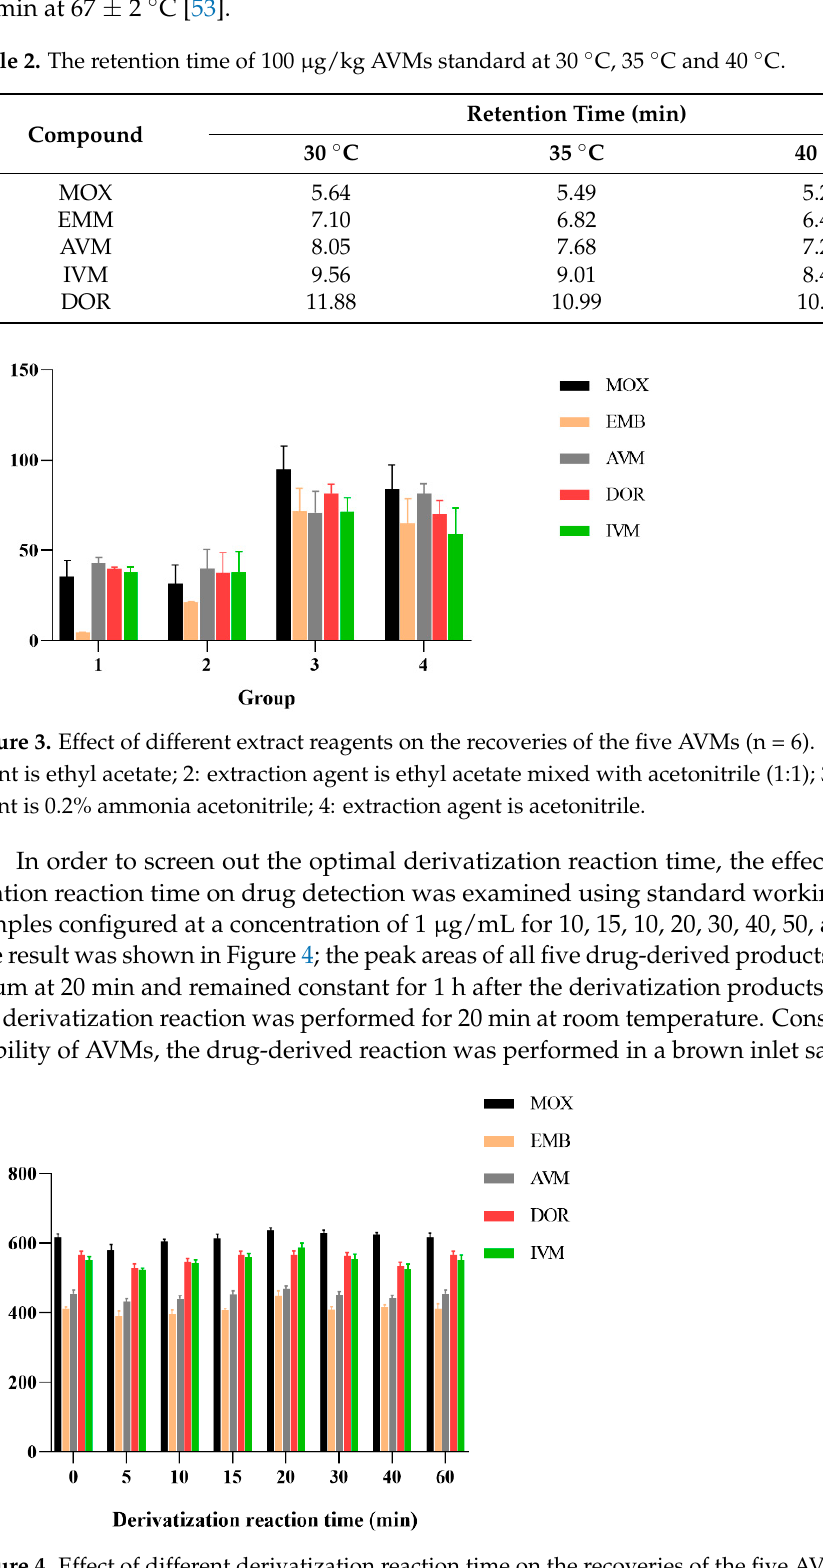
Figure 4. Effect of different derivatization reaction time on the recoveries of the five AVMs (n = 6).